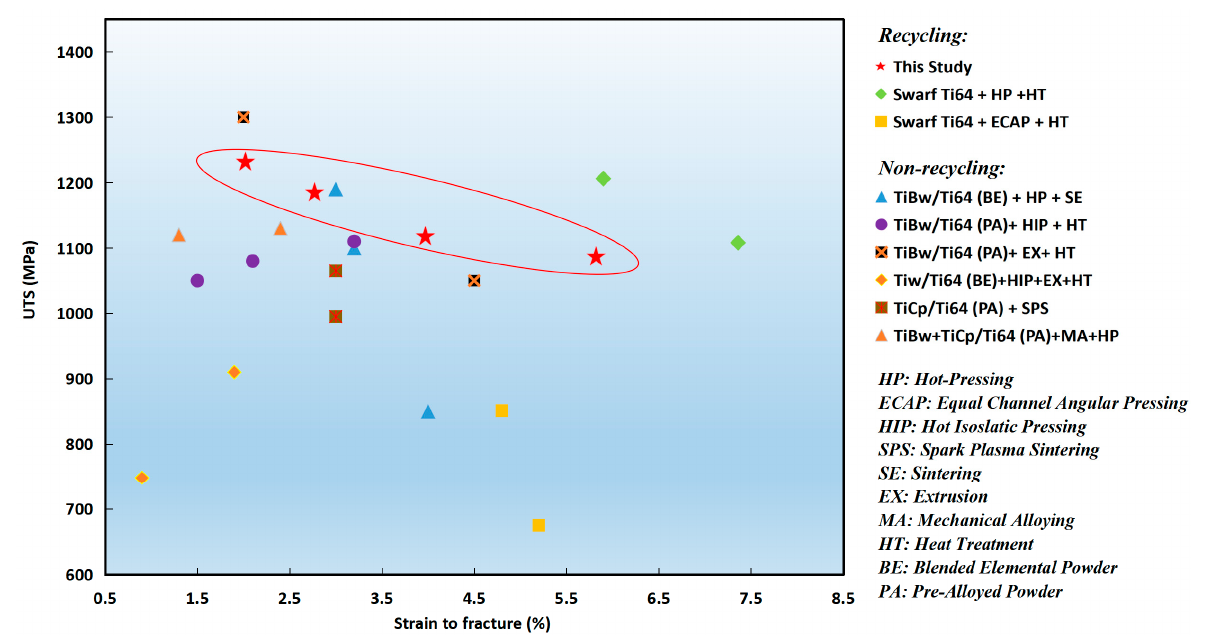
Figure 12. Comparison of tensile strength and ductility of Ti-6Al-4V alloys/composites with other approaches and raw materials [8,14,19,35,45,47,48,49,50].